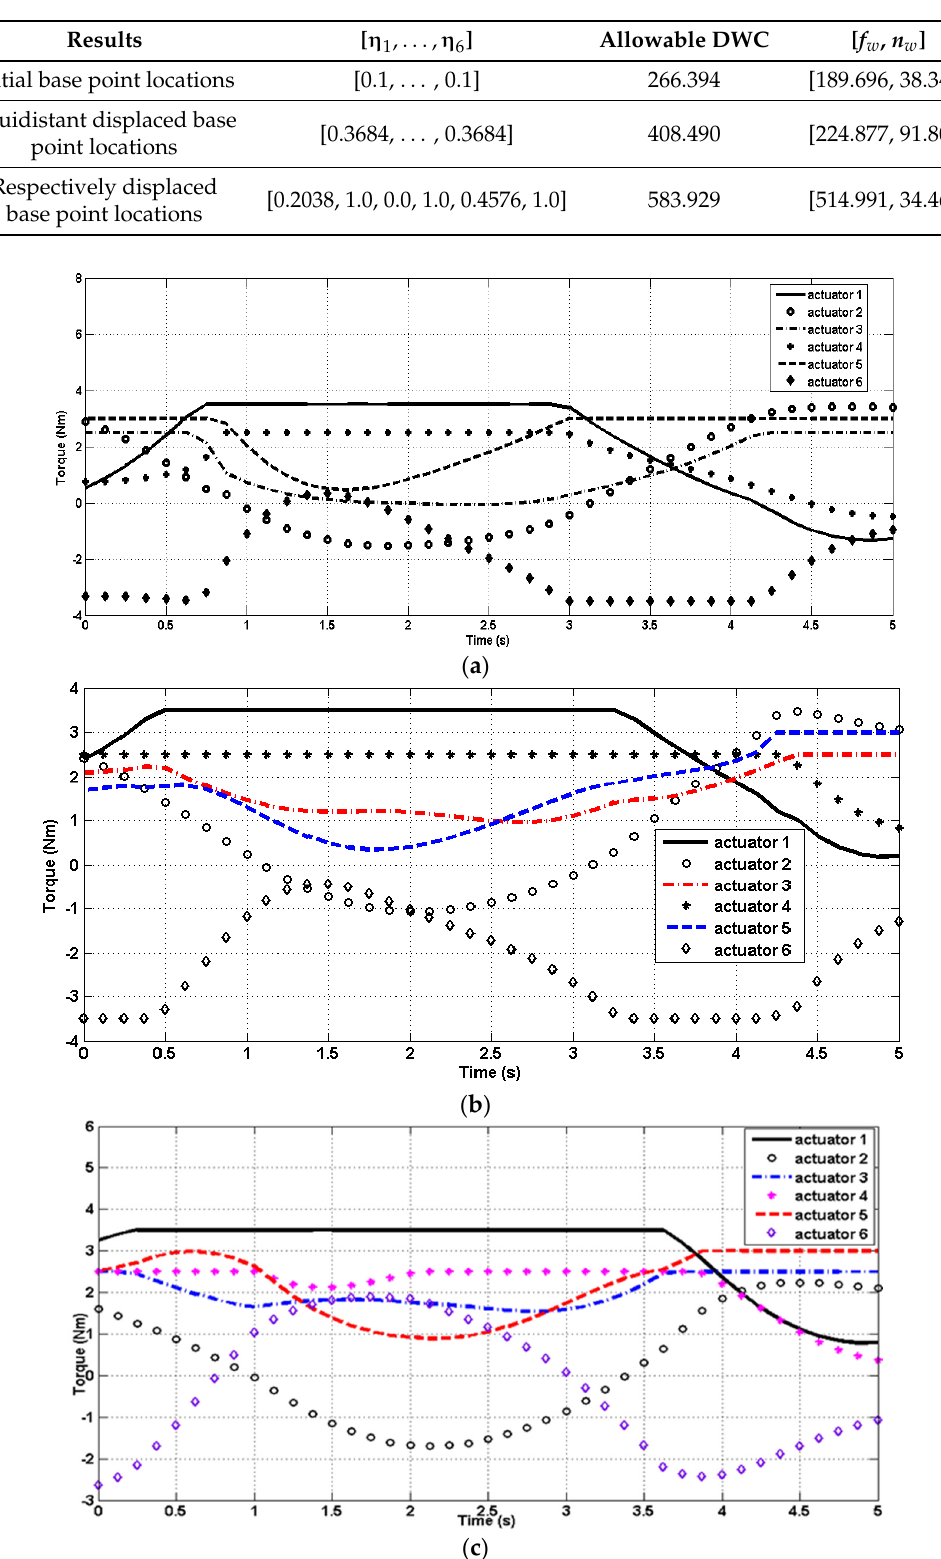
Figure 10. Torques with the maximum dynamic wrench capability for ( a ) initial; ( b ) equidistantly displaced; ( c ) individual displaced base point locations.